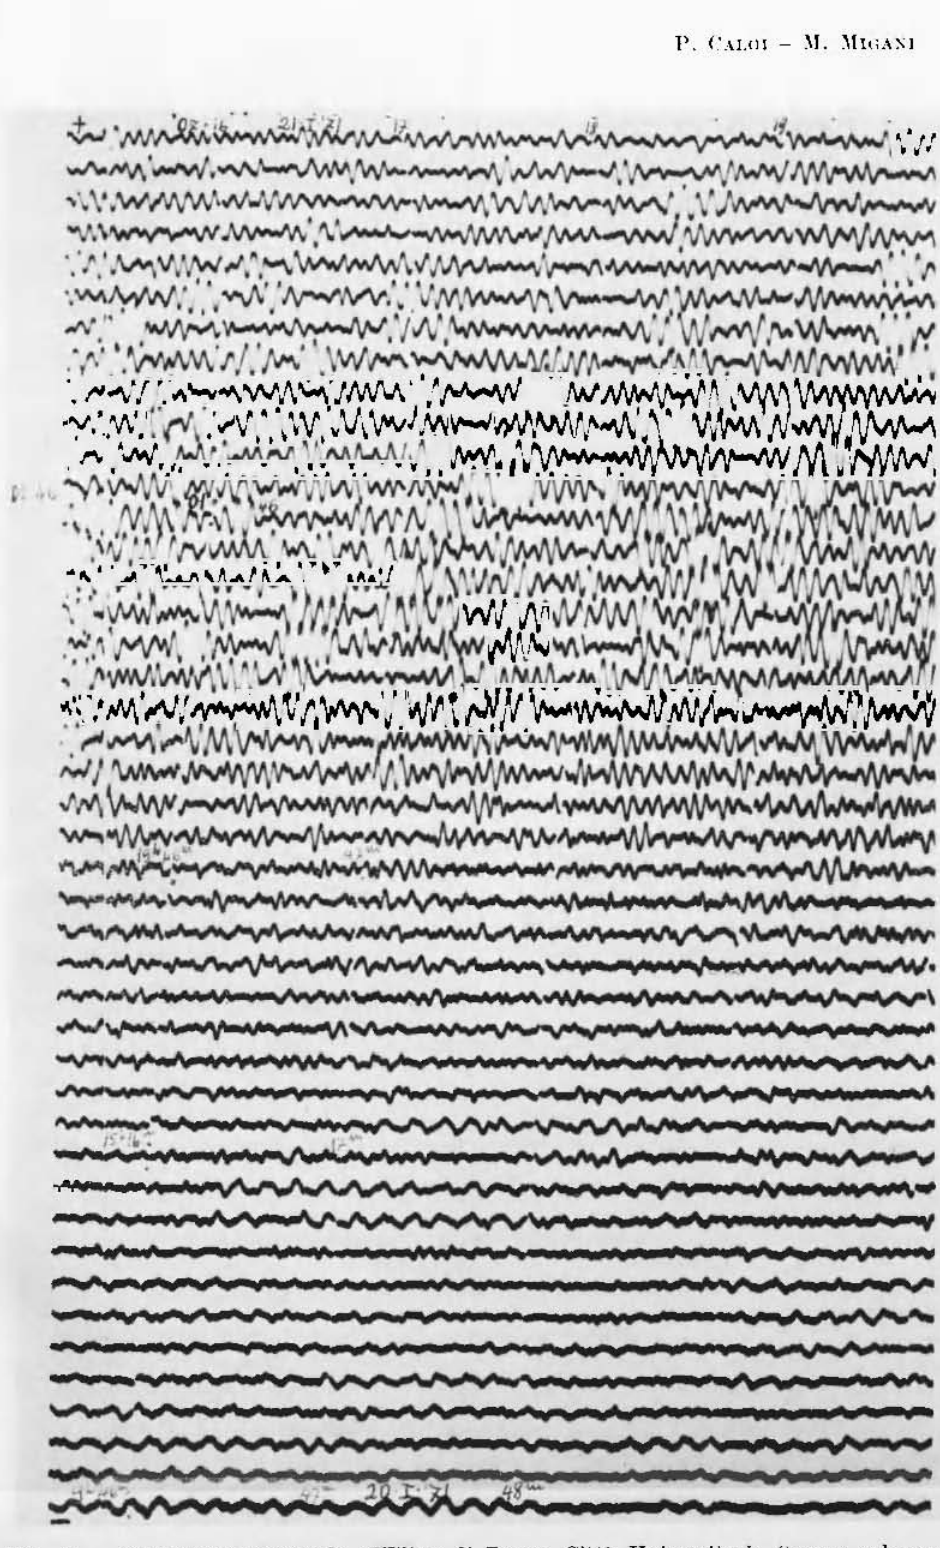
Fig. 37 _ Compouente vert,itlale • \Vilip • di Roma, Città. UniverRitaria (tempo solare me· dio). I microsismi con S" ca di periodo, tli provenienza nor!l,atlantica (figg. 34,35), verso le 10h ca del 20 Gennaio sono ancora POllO perturbati (in basso, nella figura). A mano a mano